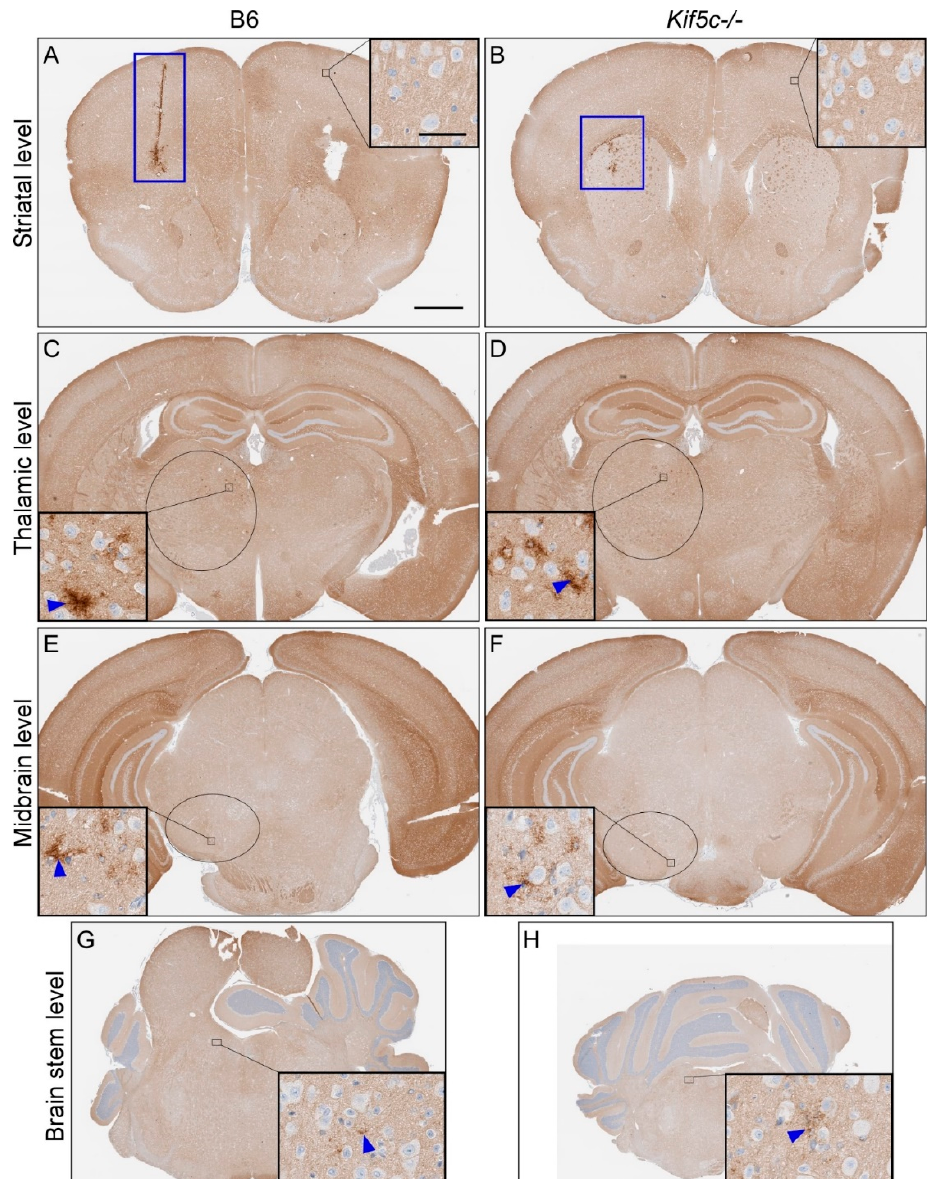
Figure 3. PrPSc staining of mouse brains 25 days post 22 L scrapie inoculation. IHC using anti-PrP antibody D13 was performed on coronal sections from four areas. A representative B6 mouse is shown on the left side, and a Kif5c − / − mouse on the right. ( A , B ) Coronal sections including the striatum. The nt is depicted with a blue box. The insets show higher magnification of the cerebral cortex with normal PrPC staining. ( C , D ) Coronal sections through the thalamus. The black oval depicts the approximate borders of the thalamus and the high magnification insets show focal PrPSc staining (blue arrowheads). ( E , F ) Midbrain sections including the substantia nigra (black ovals). Insets show higher magnification and PrPSc present in the substantia nigra. ( G , H ) Rostral pons sections and higher magnification insets showing subtle PrPSc. The scale bar in A is 1 mm and applies to all the large panels. The scale bar in the inset within panel A is 50 µm and applies to all the insets.